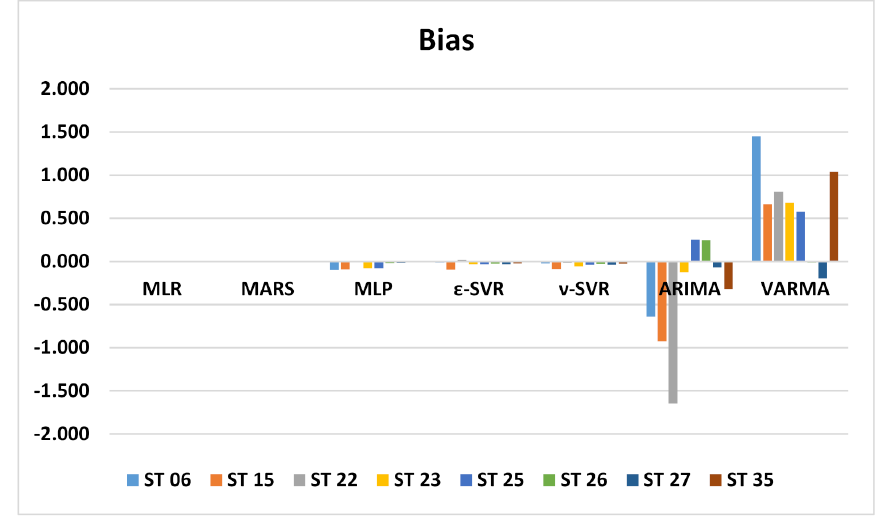
Figure 4. Bias error for all models and